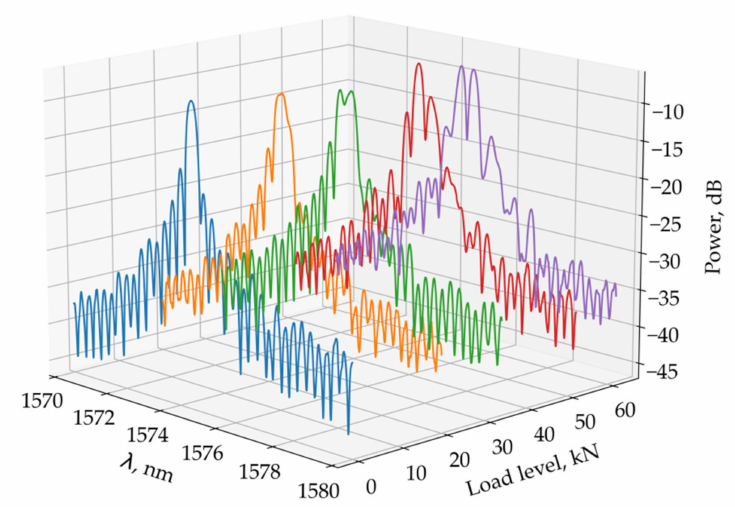
Figure 8. Reflected optical spectra of FBG under different